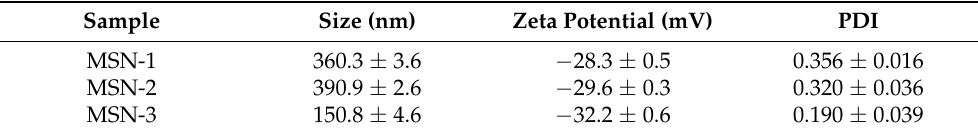
Figure 3. TEM images of MSN-1 ( a ), MSN-2 ( b ), and MSN-3 ( c ). Table 1. Particle size, zeta potential, and PDI of MSN-1, MSN-2, and MSN-3.